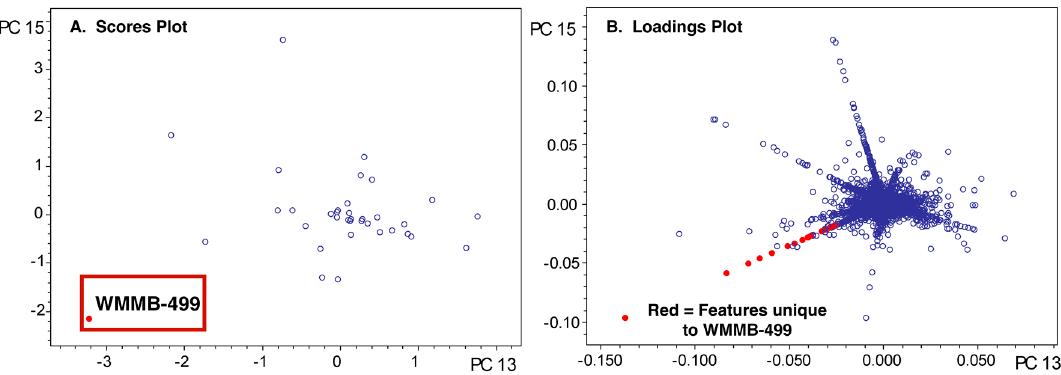
Figure 3. ( A ) The scores plot for PC15 vs. PC13 shows WMMB-499 separate from the other strains; ( B ) The loadings plot shows molecular features that are unique for WMMB-499.